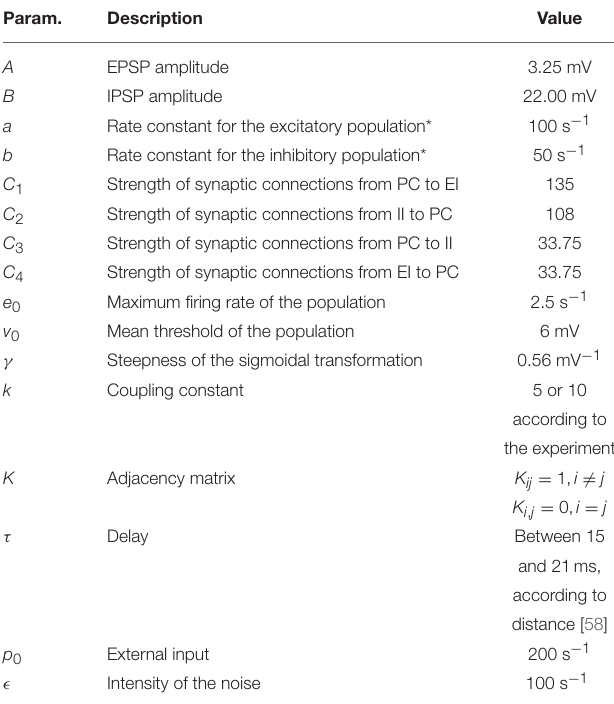
TABLE 1 | Description and default values of the parameters for the system of neural masses.